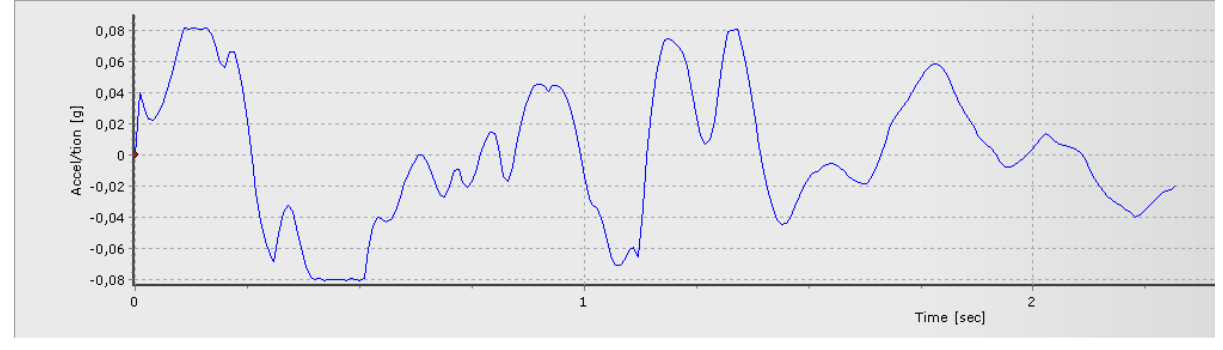
Figure 6. Acceleration.